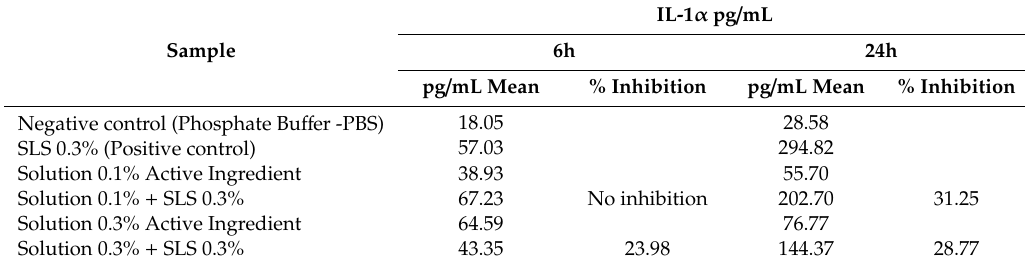
Table 1. Results of the inhibition of IL-1 α